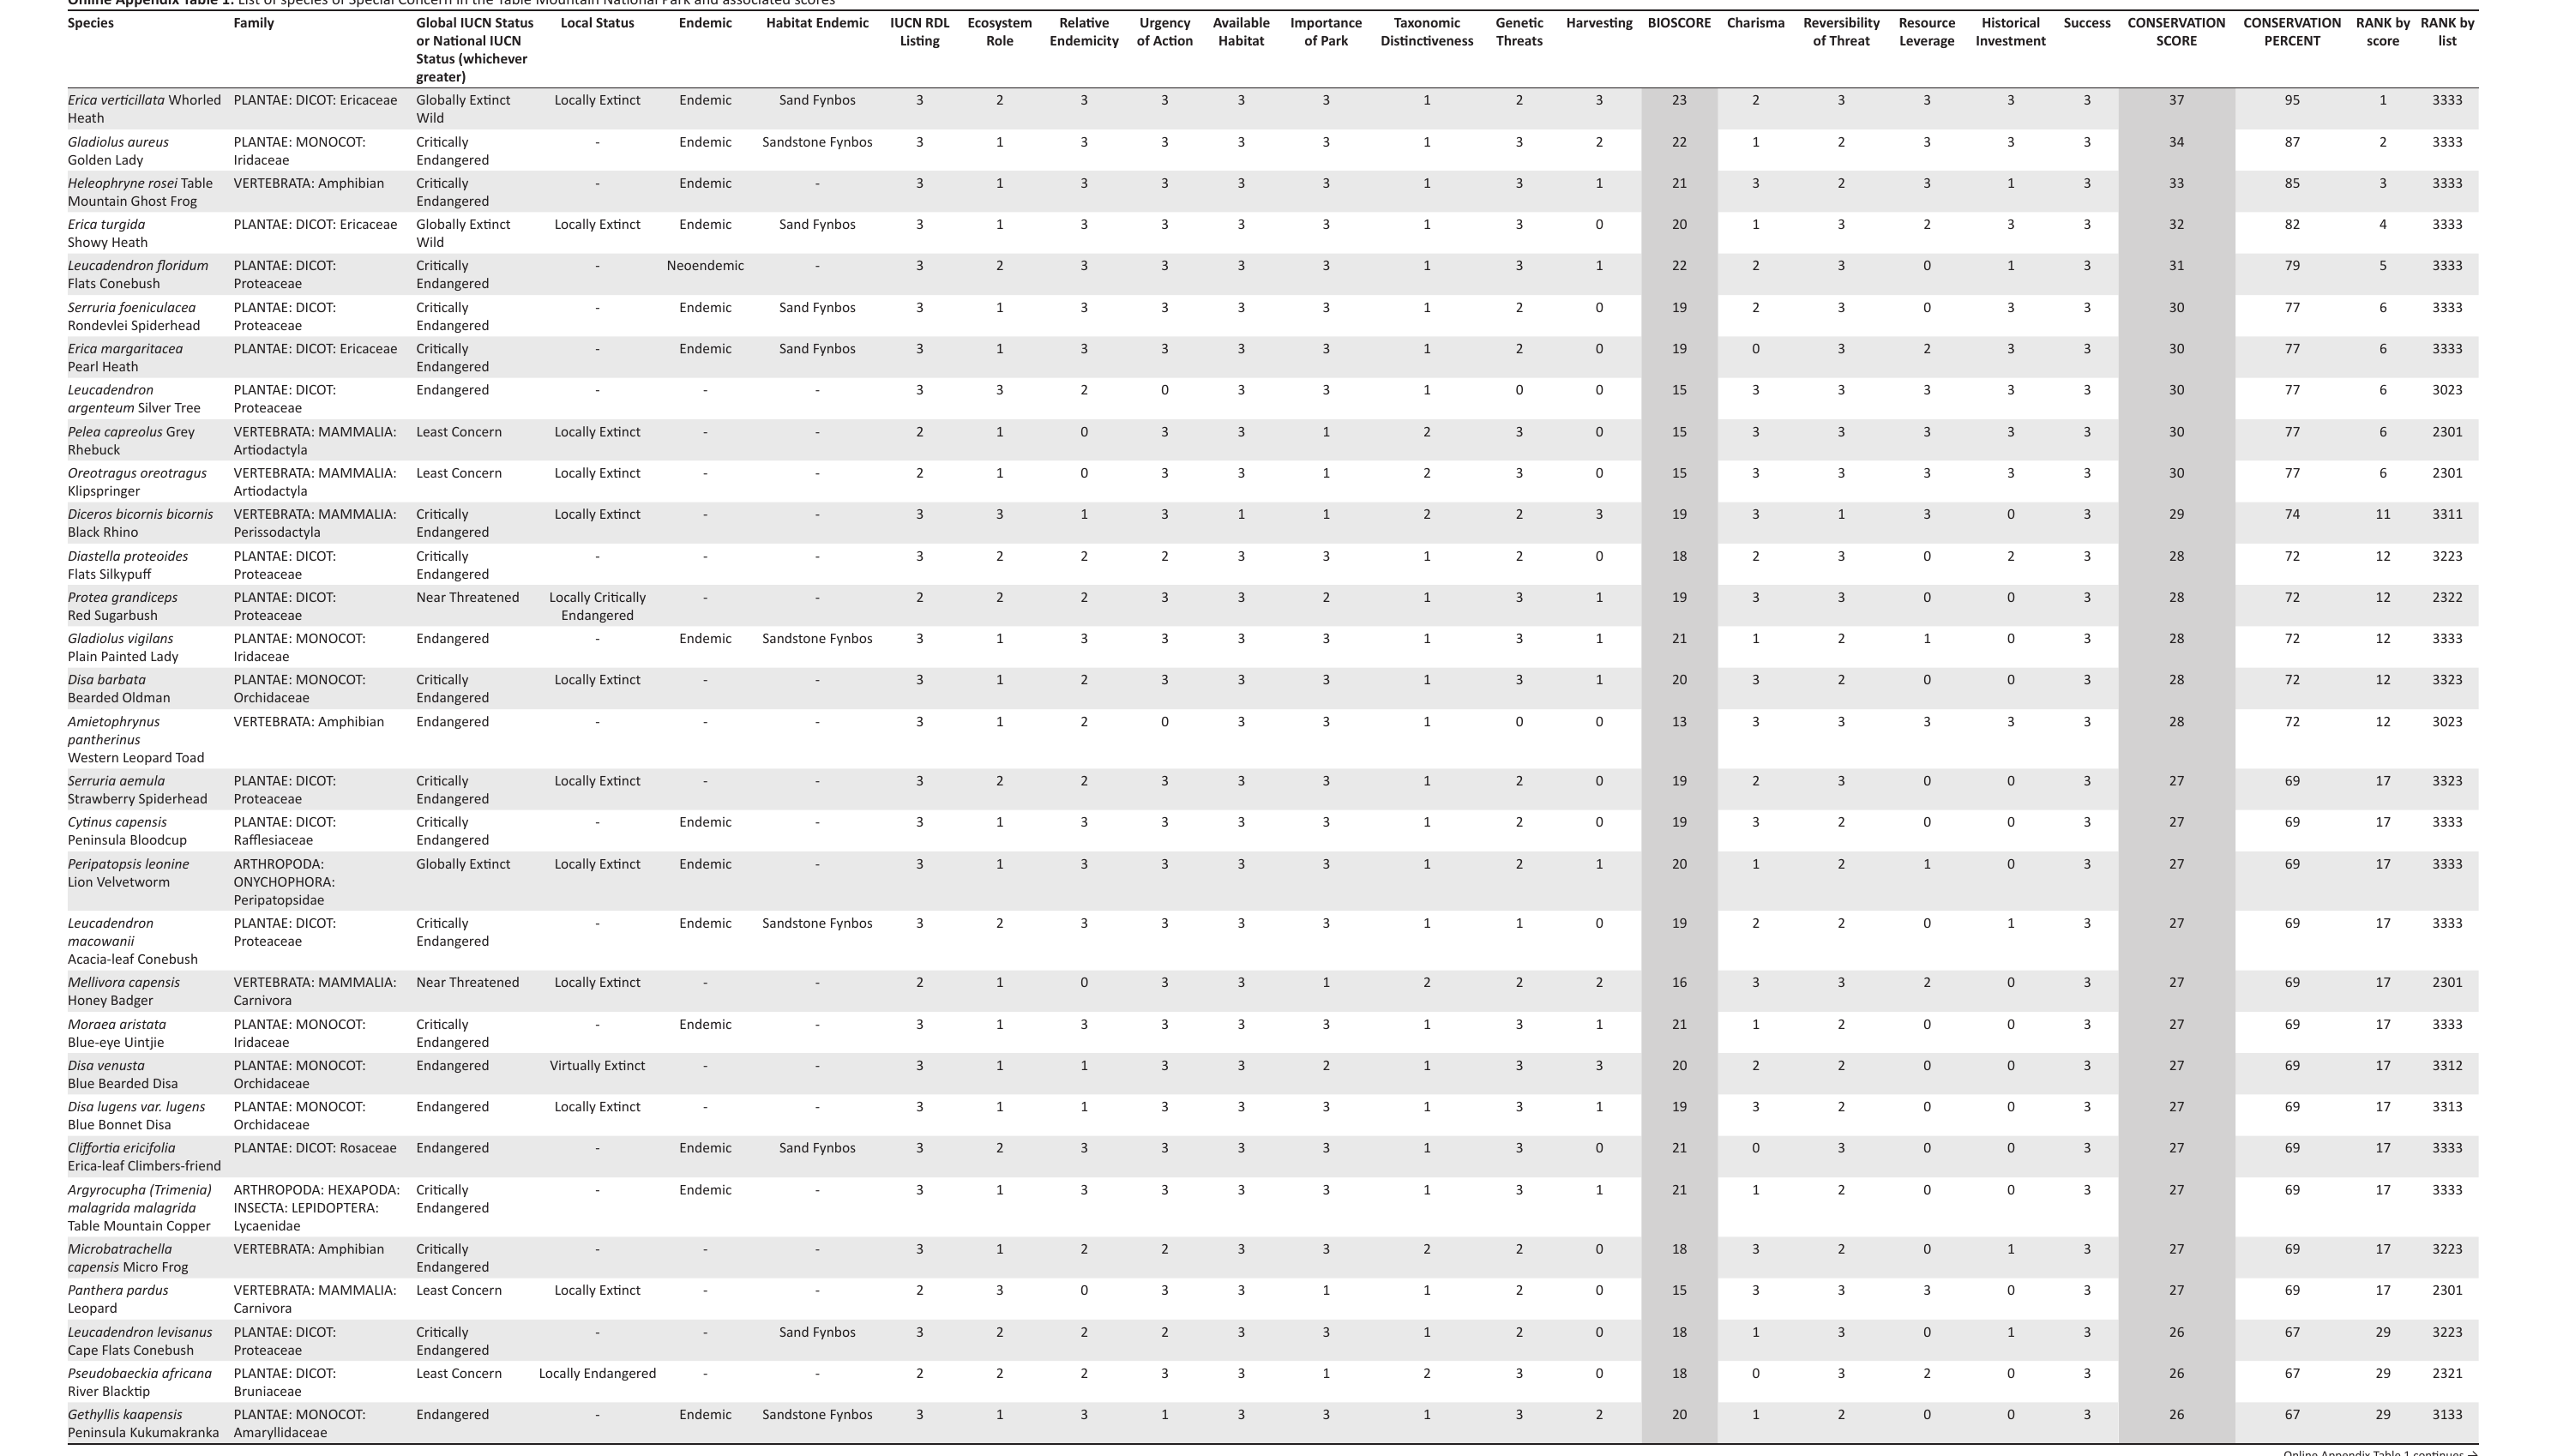
Cliffortia ericifolia Erica-leaf Climbers-friend Table Mountain Copper Microbatrachella capensis Micro Frog Panthera pardus Leopard Pseudobaeckia africana River Blacktip Gethyllis kaapensis Peninsula Kukumakranka